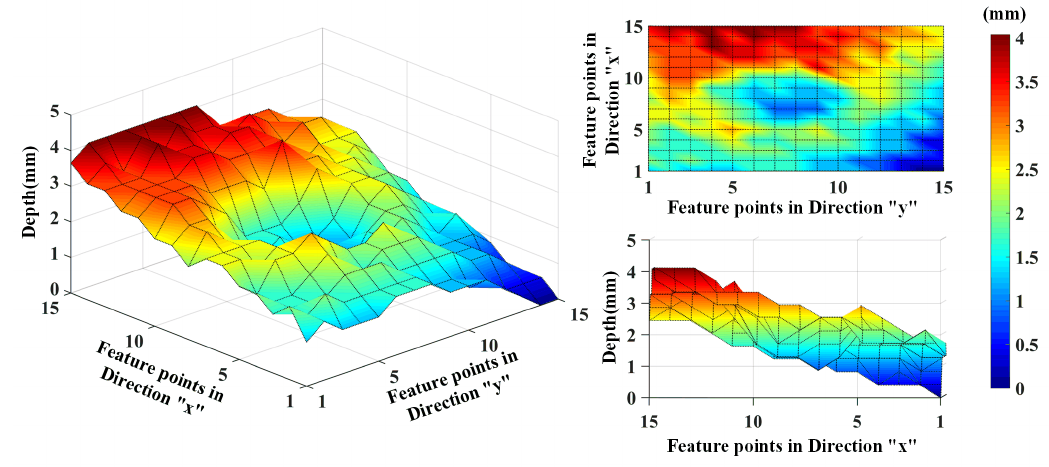
Figure 14. The 3D depth map of the rail surface with the depth information of the 15 × 15 feature points.